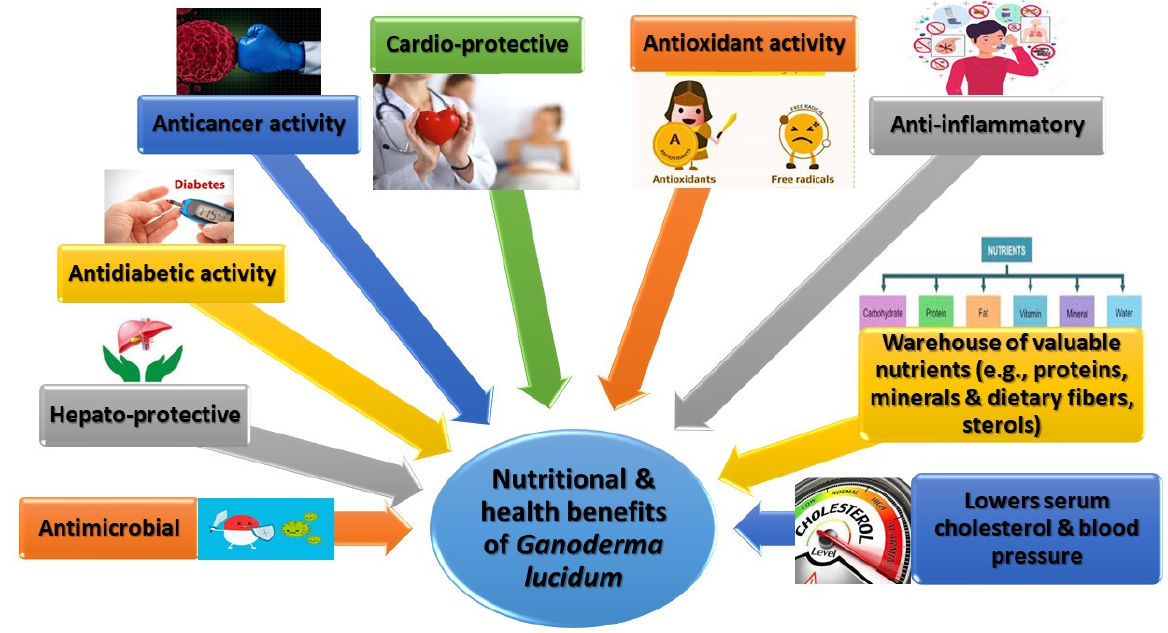
Figure 4. Nutritional and health benefits conferred by Ganoderma lucidum .